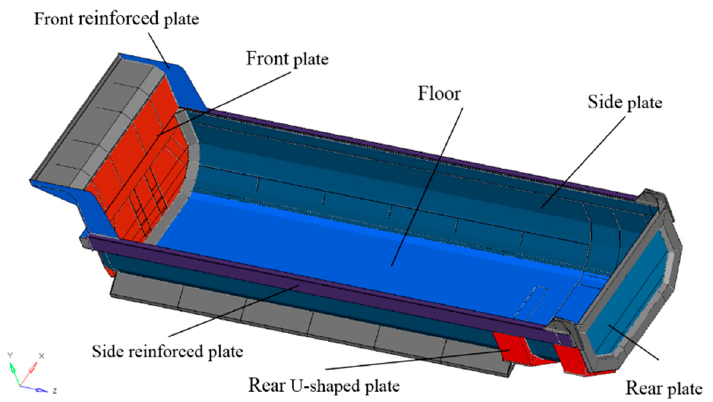
Figure 3. U-shaped carriage of dump truck. Table 1. Material basic properties of high-strength steel used for carriage.